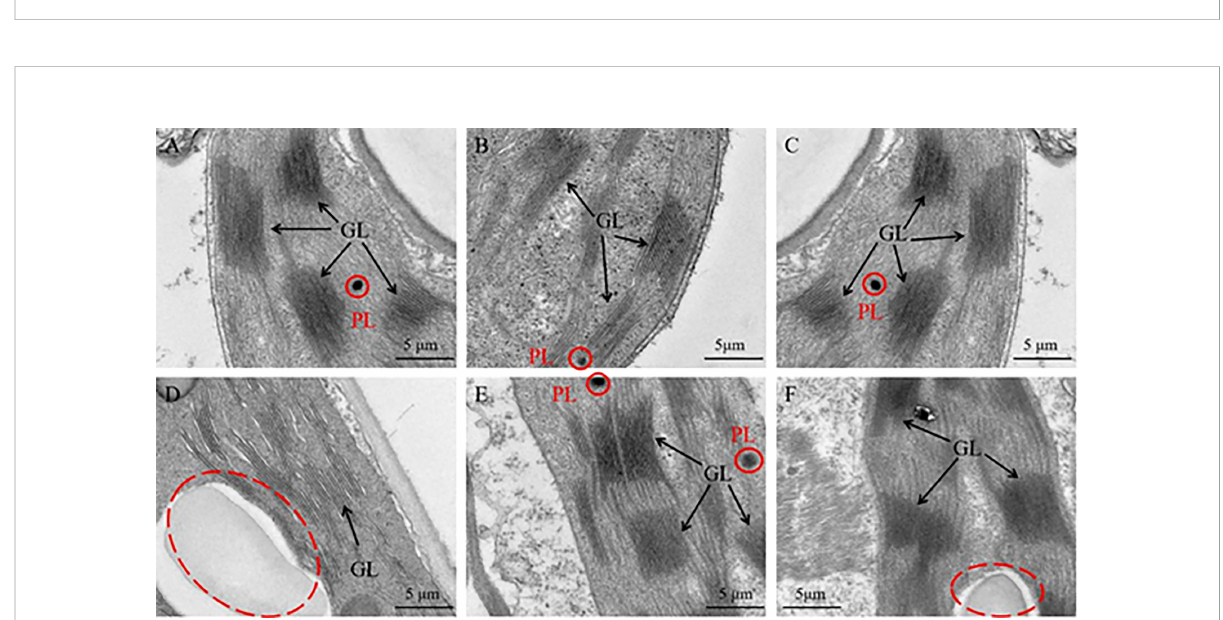
FIGURE 11 Ultrastructure of the chloroplast. (A) Chloroplast ultrastructure of blank control, Chloroplast ultrastructure of silencing gene (B) Cla97C02G036010 , (C) Cla97C02G036030 , (D) Cla97C02G036040 , (E) Cla97C02G036050 and (F) Cla97C02G036060 , respectively. GL represents grana lamella, PL represents plastoglobuli (red circle). The scale is 5 m